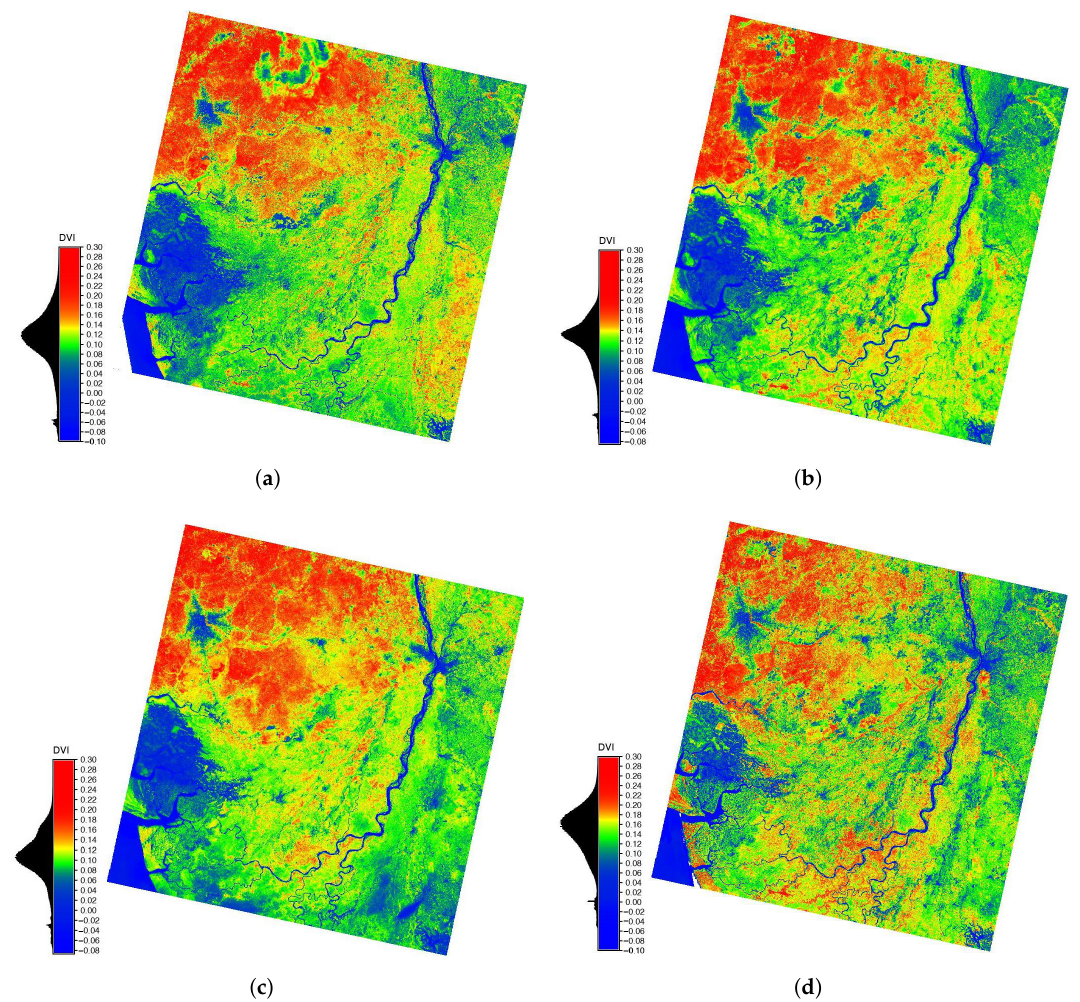
Figure 3. DVI of the Landsat 8-9 OLI/TIRS of Niger River Delta: ( a ) 2013, ( b ) 2015 ( c ) 2021, ( d )